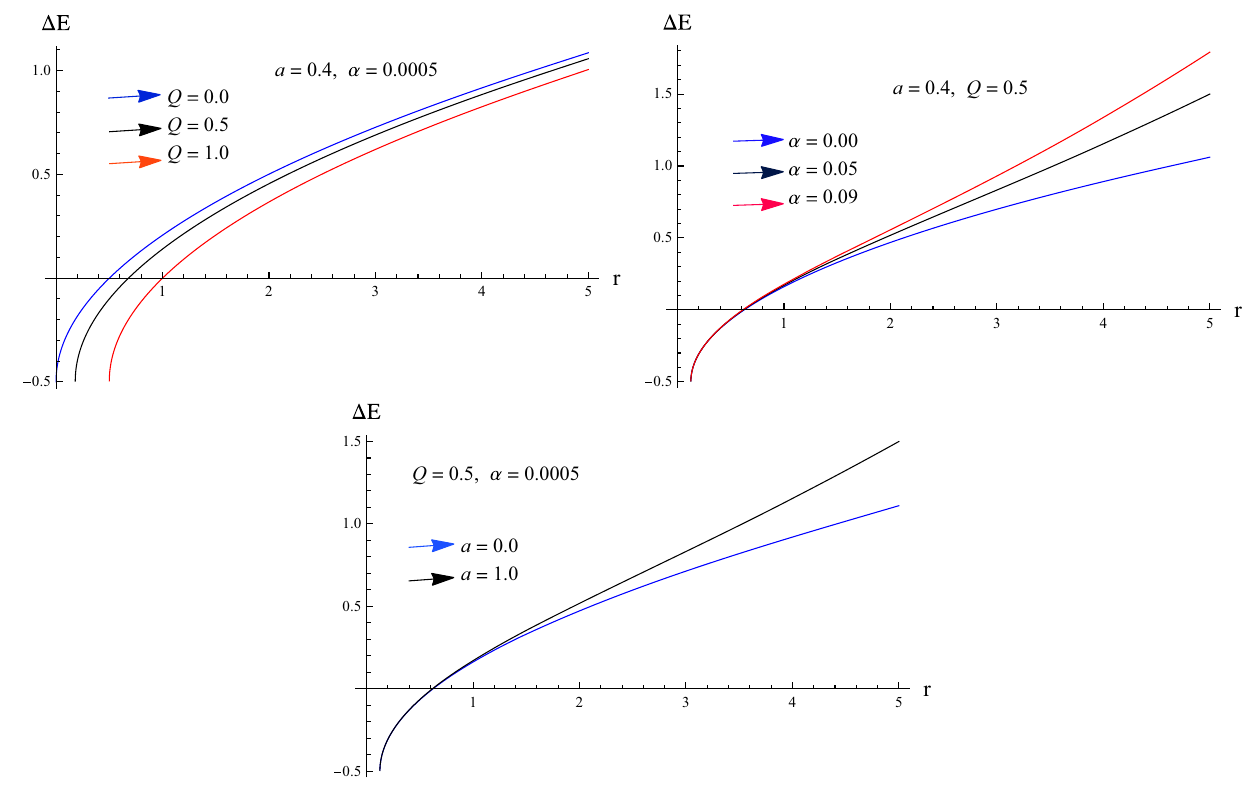
Fig. 8 Plots of energy gain as a function of r